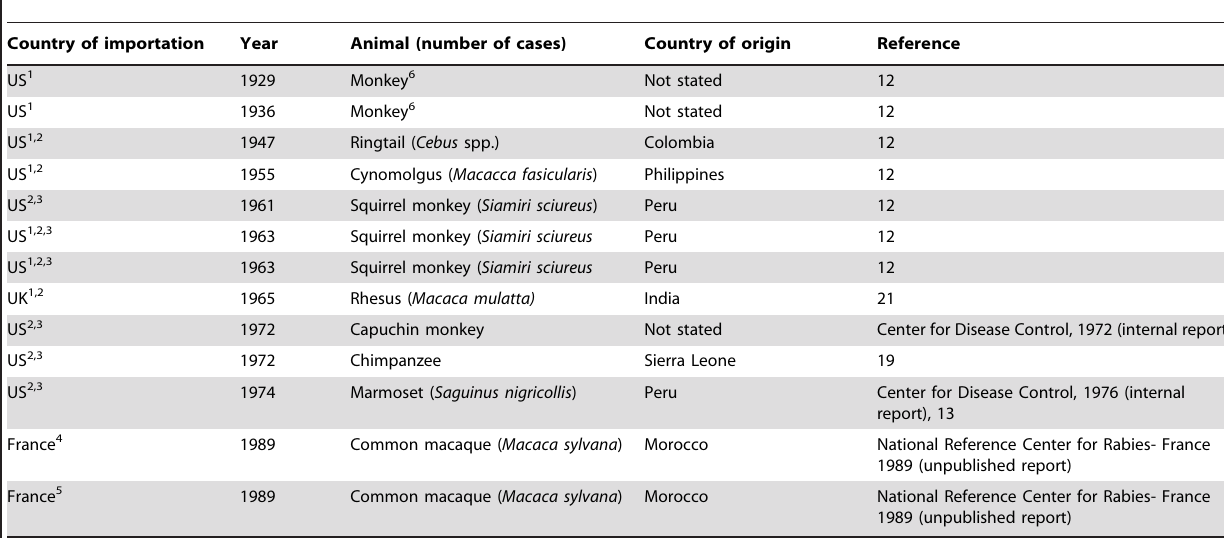
Table 2. Confirmed rabies in imported nonhuman